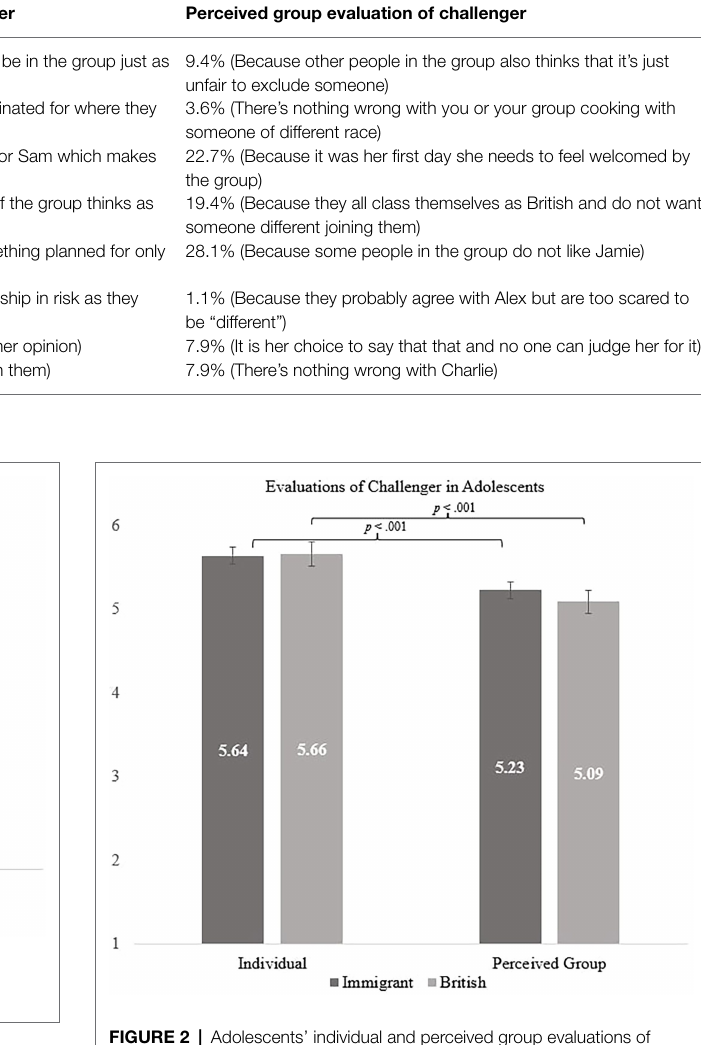
FIGURE 2 | Adolescents’ individual and perceived group evaluations of challenger by exclusion condition.